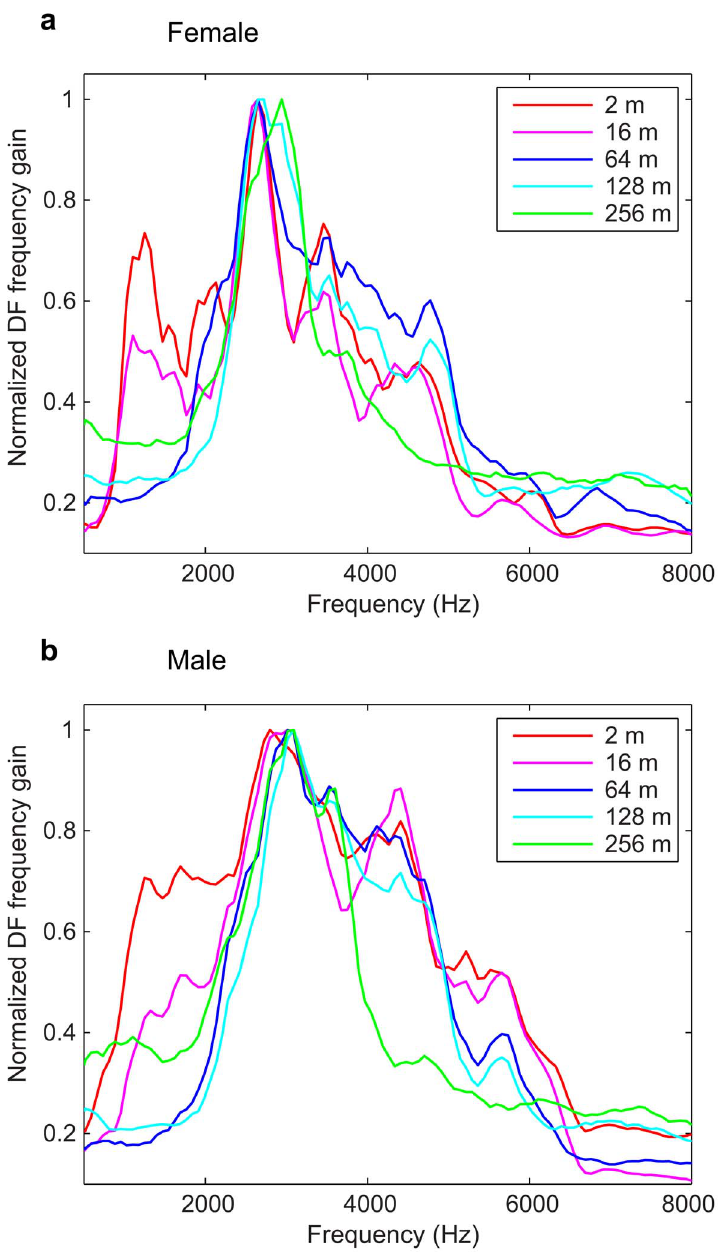
Figure 10. Relative importance of the discriminant functions (DFs) as a function of frequency. Calculations are shown for females (a) and males (b), for every propagation distance. These importance functions were obtained by calculating the normalized mean of the absolute values of the first 4 DFs for each frequency window. This analysis shows the frequencies that are the most useful to discriminate between individuals at each distance.